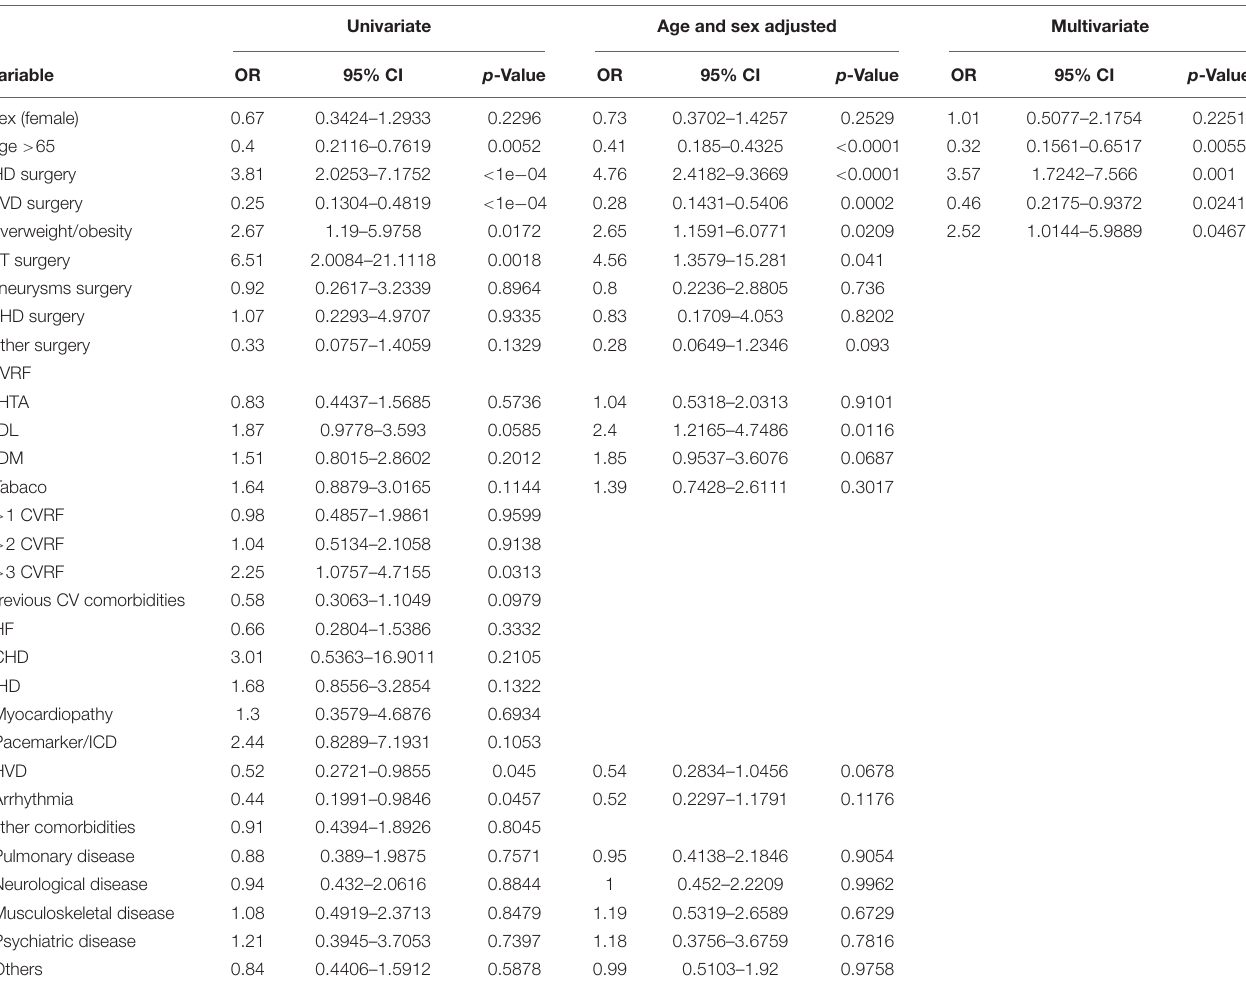
TABLE 3 | Predictors of phase II cardiac rehabilitation program following cardiac